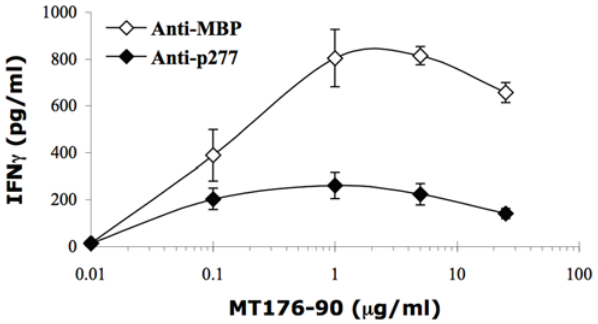
Figure 7. HSP60-specific Anti-ergotypic T-cells control arthri- togenic T-cells invitro . LNC from Mt immunized rats (2.5 6 10 5 per well) were activated with Mt176-90 for 72 hr in the presence of Anti- p277 or Anti-MBP T-cells (5 6 10 4 per well). The secretion of IFN c was determined by ELISA, the results are presented as pg/ml 6 SEM of triplicate cultures. The differences between the groups were significant (p , 0.05) for antigen concentrations higher than 0.1 m g/ml. Three independent experiments produced similar